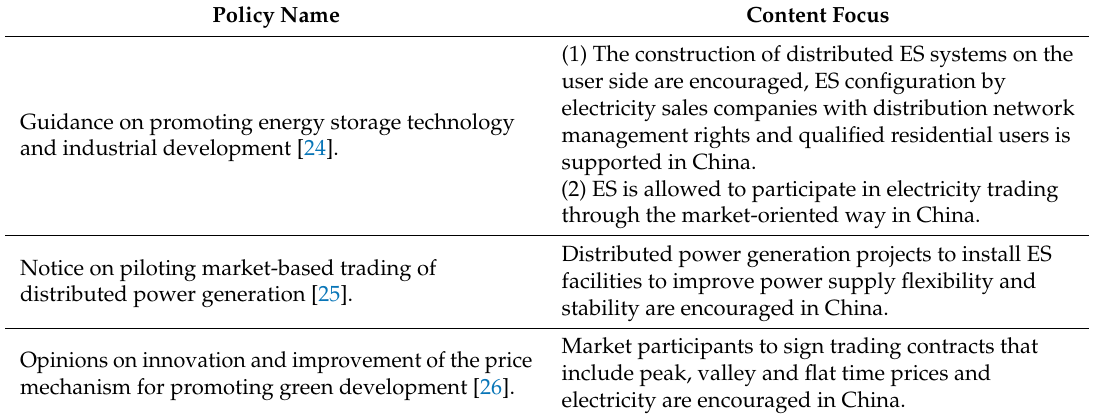
Table 1. Partial support policy of user side energy storage (ES) in